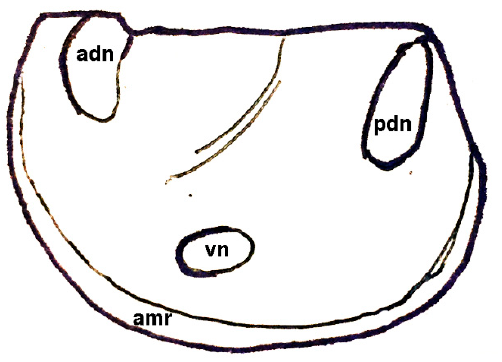
Figure 14. Hanchiangella minor . Anterior to left. Length of shield approximately 3.5 mm. Abbreviations: adn , anterodorsal node; amr , admarginal rim; pdn , posterodorsal node; vn , ventral node. Image Credit: Mark McMenamin.